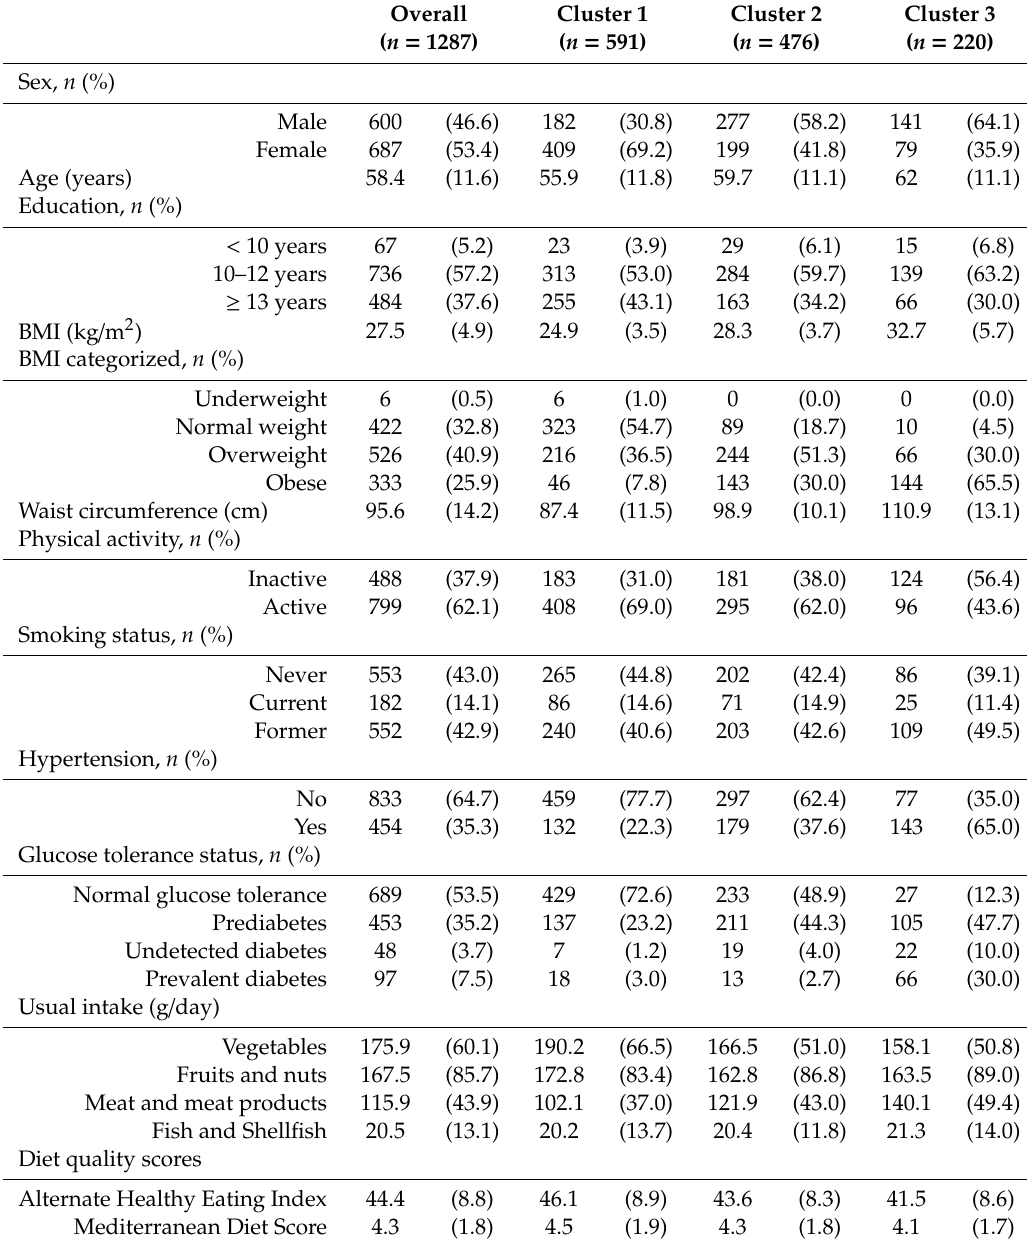
Table 3. Characteristics of the study population overall and by